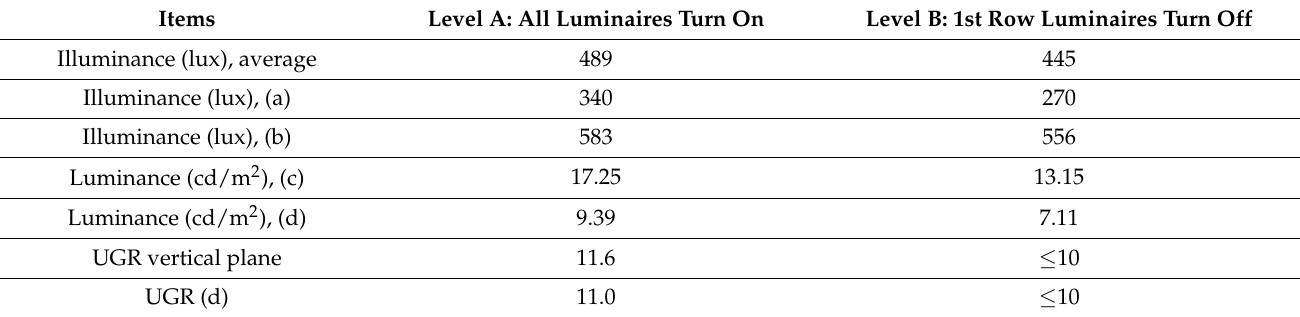
Figure 13. Asymmetric distribution of LED light tube ( a ) can be installed in conventional symmetric luminaires ( b ). The red line refers to planes C0–C180, blue line refers to planes C90–C270. Unit: cd/klm. Table 8. Photometric data of the asymmetric distribution LED tube.